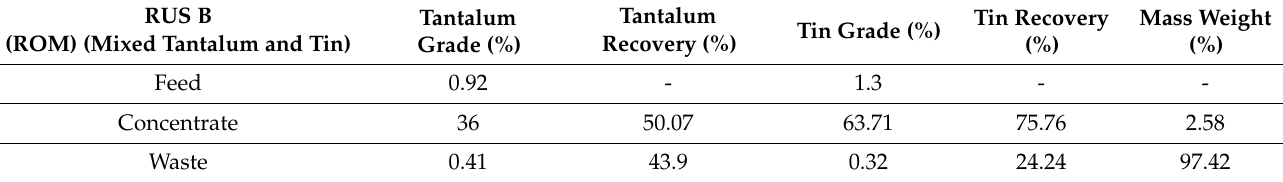
Table 4. RUS B mechanized processing results.